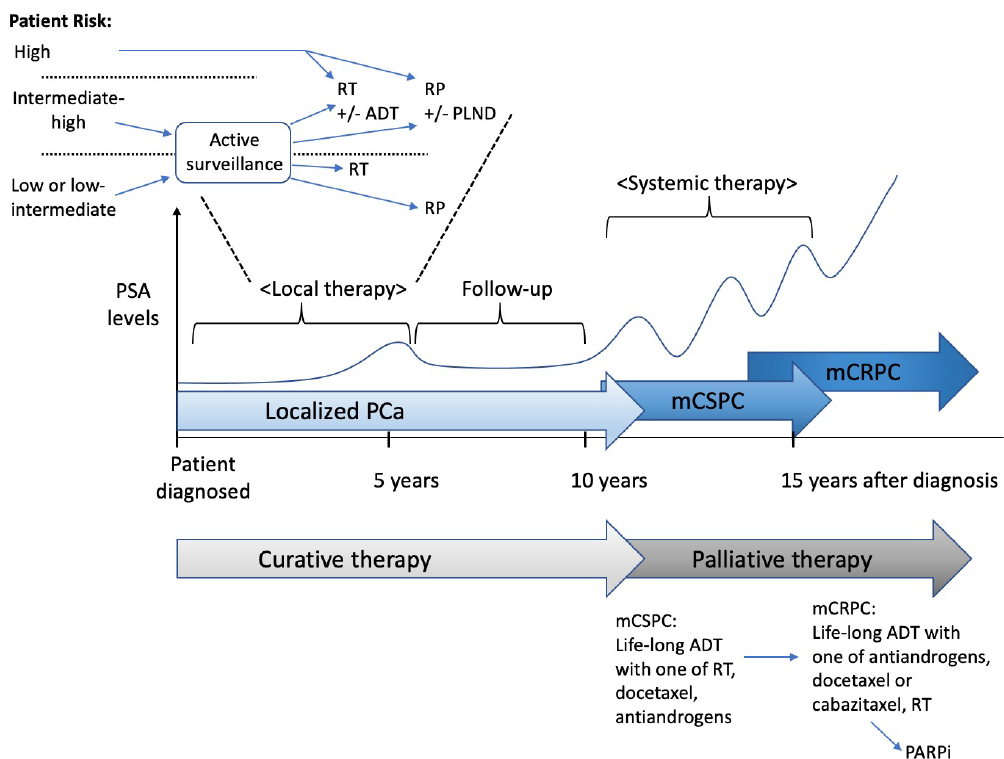
Figure 1. Management overview of prostate cancer. Patients with localized prostate cancer are predominantly managed with either active surveillance or local treatment. The division into low-, intermediate-, and high-risk prostate cancer uses multiple parameters, such as the number of cancer- positive biopsy cores, the length of tumor architecture in the cores, molecular signatures, and imaging results, and inform the decision between active surveillance, single modality therapy, or multimodality therapy. Prostate-specific antigen (PSA) level since diagnosis, indirectly representing the tumor burden, increases in patients whose prostate cancer fails to respond to local and systemic therapies in the progression to metastatic disease. The aggressive prostate cancers are associated with the progression from localized to metastatic castration-sensitive prostate cancer (mCSPC) and metastatic castration-resistant prostate cancer (mCRPC). The treatment approach is switched from curative to palliative care in the disease progression. ADT: androgen deprivation therapy, PARPi: poly(adenosine diphosphate–ribose) polymerase inhibitor, PLND: pelvic lymph node dissection, RP: radical prostatectomy, RT: radiotherapy.